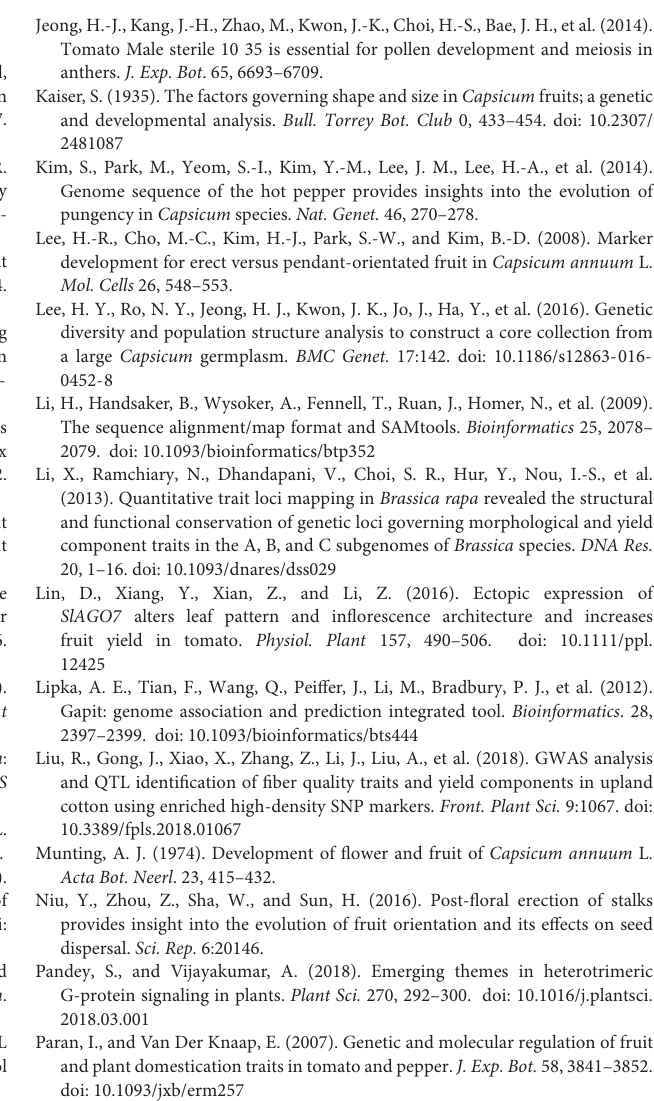
Supplementary Figure 1 | Intermediate fruit orientation phenotypes. (A) Lateral pendent phenotype. (B) Lateral upright phenotype. Supplementary Figure 2 | Frequency distribution of traits related to fruit orientation. Pedicel length, pedicel thickness (width), and fruit weight of the PD and MJ F 2 populations associated with the erect and pendent fruit orientations.